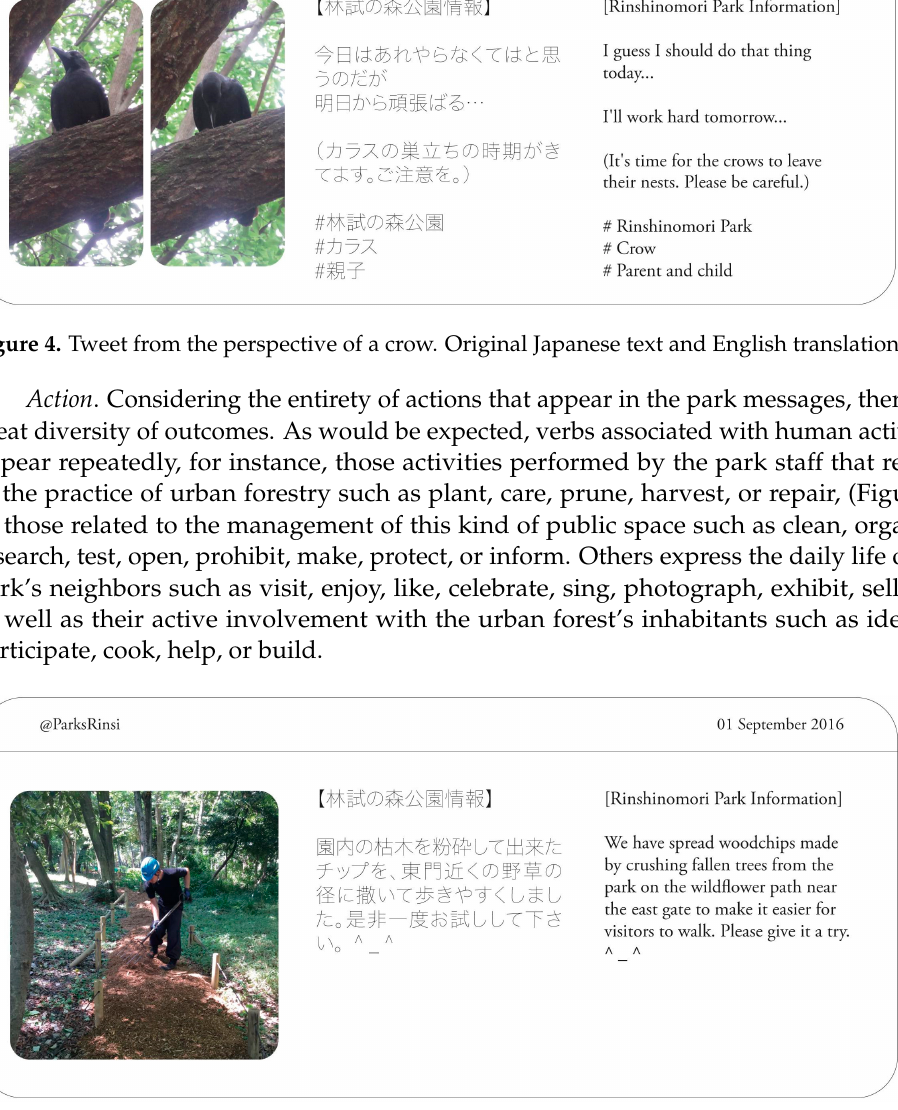
Figure 5. Tweet expressing actions of care carried by the park workers. Original Japanese text and English translation